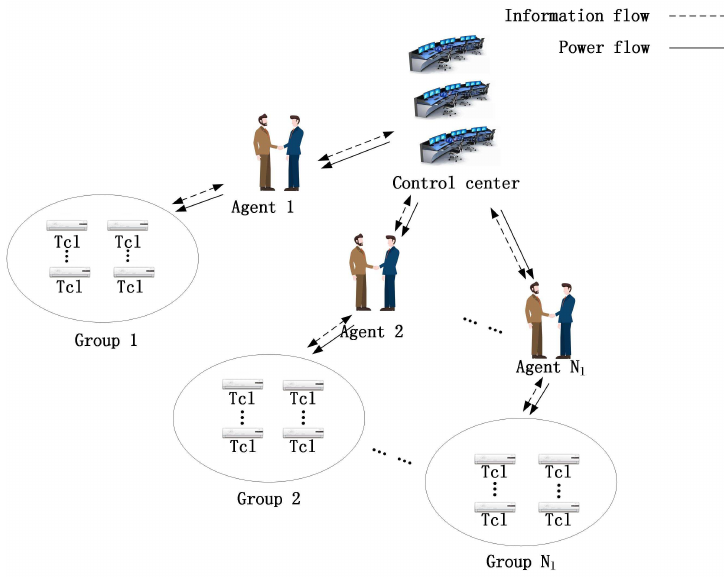
Figure 1. System